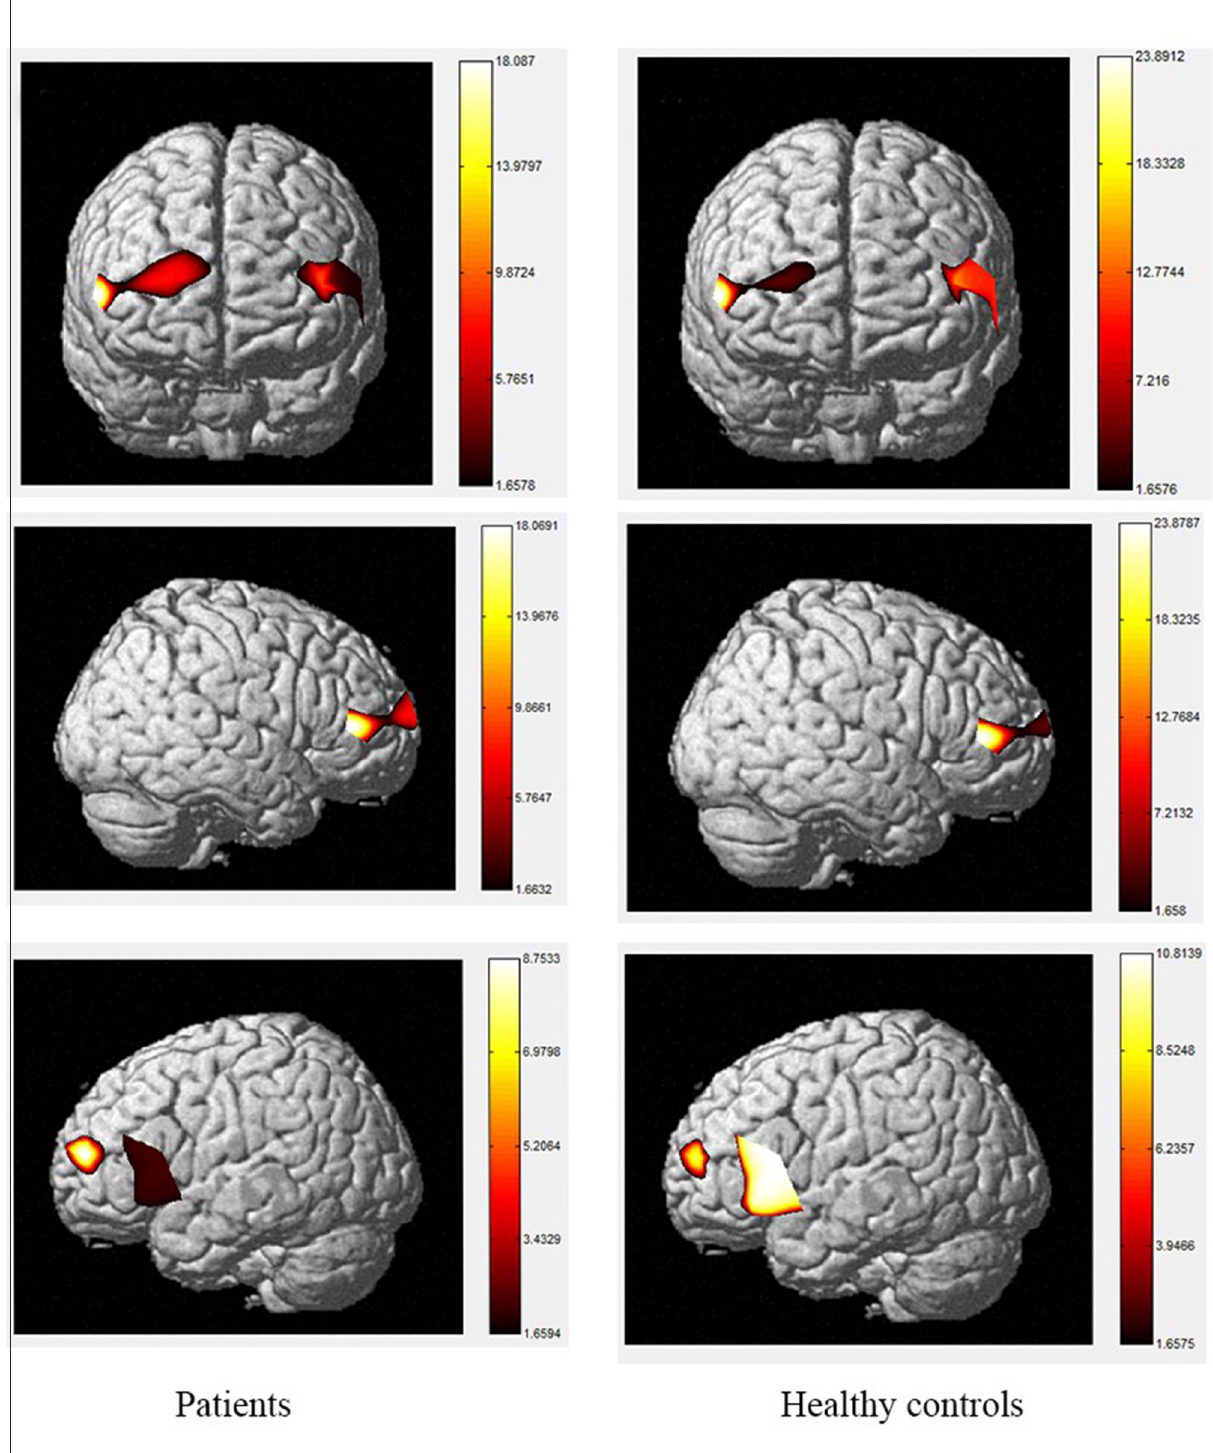
FIGURE2 The activation of brain areas during the color word consistency Stroop tasks between patients and healthy controls. The color bars in right sides mean the activated strength of brain